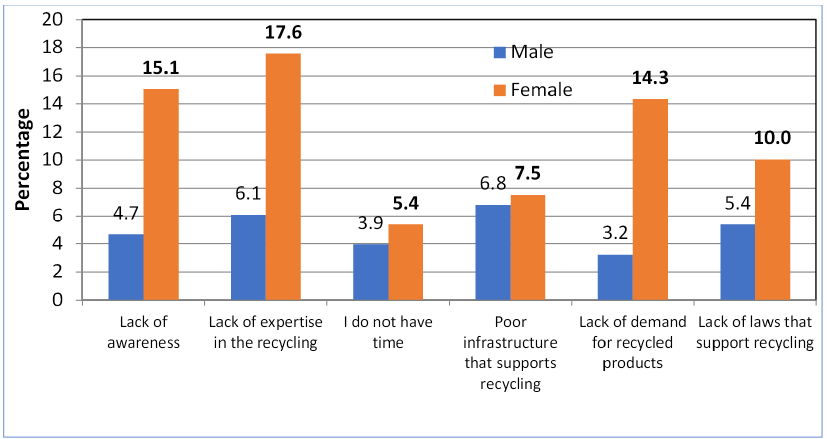
Figure 1. Reasons for not recycling waste at source. Chi-square, χ 2 = 12.5, p = 0.024. The chi-square test result suggested significant association between gender and reasons for not recycling the waste at source ( p = 0.024).